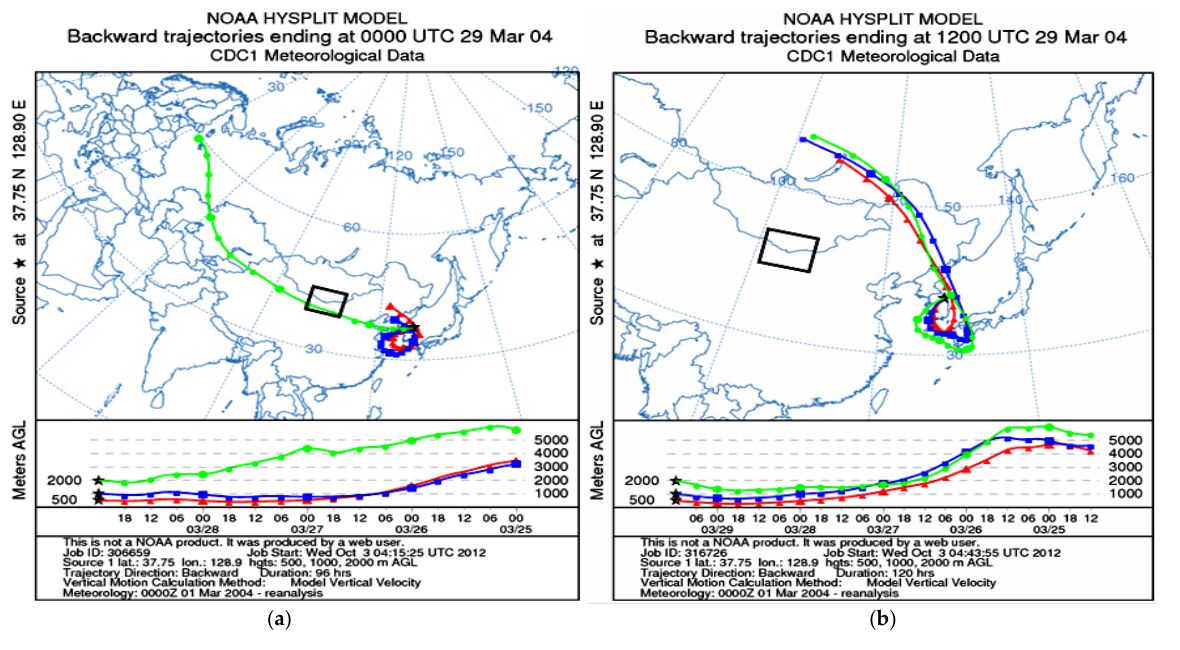
Figure 5. Backward trajectories of air masses by NOAA HYSPLIT model for 4 days were at 2000 m, 1000 m, and 500 m heights of Gangneung city, ending at ( a ) 00:00 UTC (09:00 LST), 29 March 2004, and ( b ) 12:00 UTC (21:00 LST). Air particles reaching 500 m, 1000 m, and 2000 m heights of Gangneung city should not influence the increases of ground-based PM of the city, even though air trajectory over 5000 m height passed through the Gobi Desert and finally reached 2000 m height of Gangneung city, which was too high to be away from the ground surface.